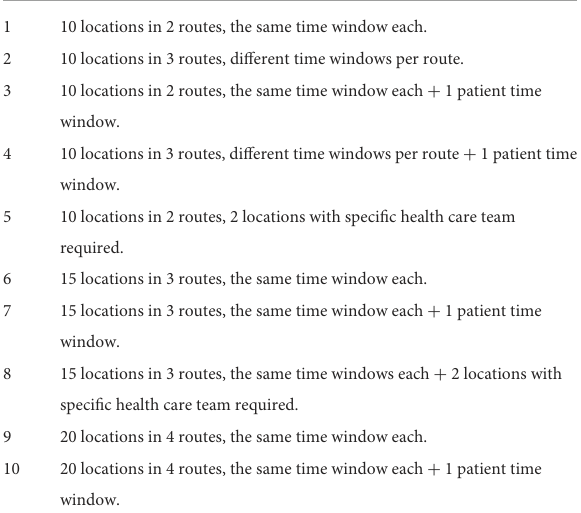
TABLE 1 Plans’ specifications and their